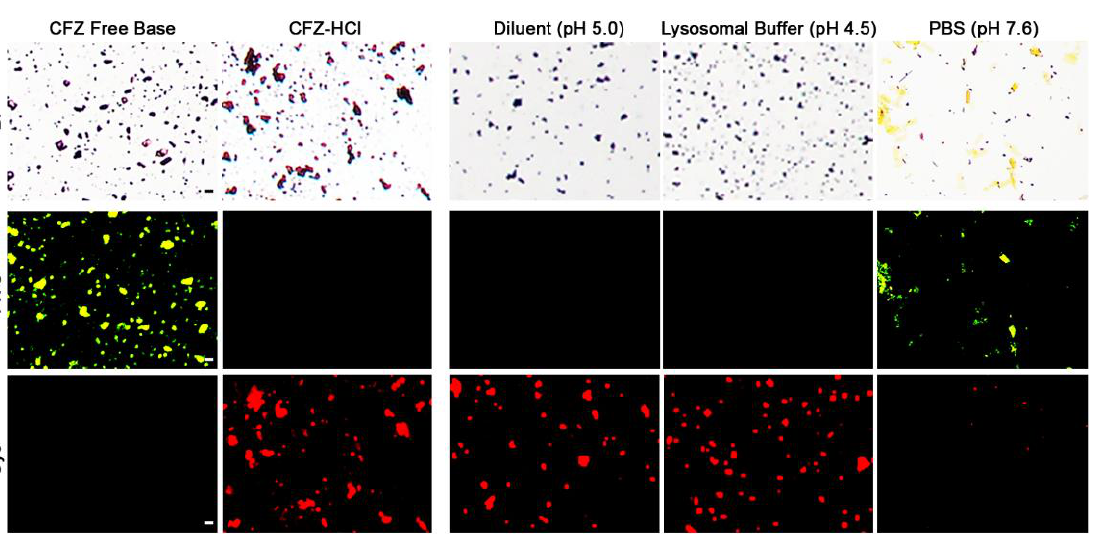
Figure 4. In vitro stability of the biomimetic formulation of micronized CFZ-HCl salt crystals in IV diluent, synthetic lysosomal buffer, and PBS after 24 h utilizing brightfield and fluorescent (FITC, Cy5) microscopy. Scale bar = 5 µm.